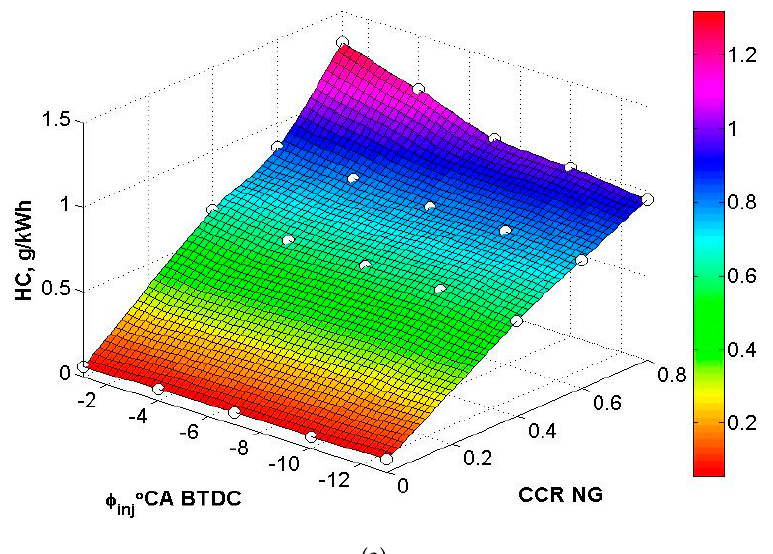
Figure 7. Influence of dual-fuel CCR NG portion and ϕ inj on CO emissions ( n = 2000 min (cid:2879)(cid:2869) ) : (a) HLM; (b) MLM; (c) LLM. The dots in the graph represent the experimental data.